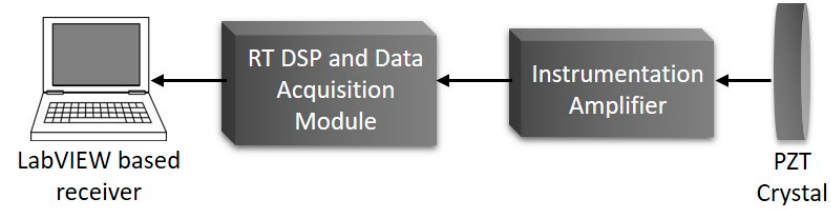
Figure 9. PPM guided waves receiver instrumentation block diagram.